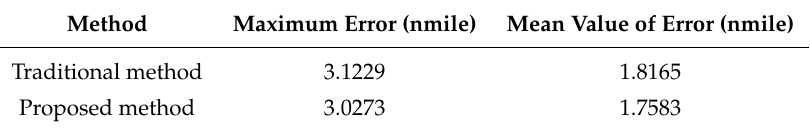
Figure 11. Positioning error of static navigation. Table 6. Static navigation